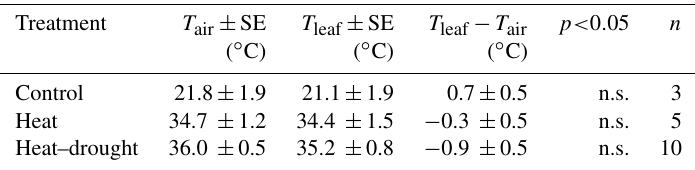
Table A1. Air temperature ( T air ) and corresponding leaf tempera- ture ( T leaf ) including standard errors are given for the control, heat and heat–drought treatment. Leaf temperature was measured with an infrared camera on 2 days during the second heatwave. Differ- ences between leaf and air temperature were not significant (pair- wise t -test p> 0 . 05).